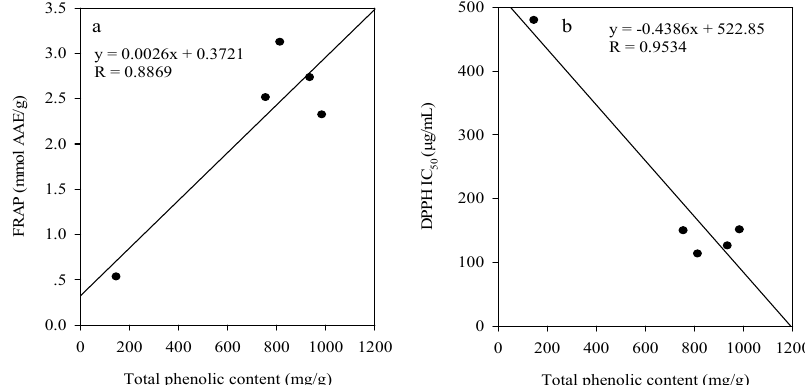
Figure 2. Relationships between the total phenolic content and the ferric reducing power (a); the total phenolic content and the free radical scavenging activity (b) of the five extracts of S . cumini